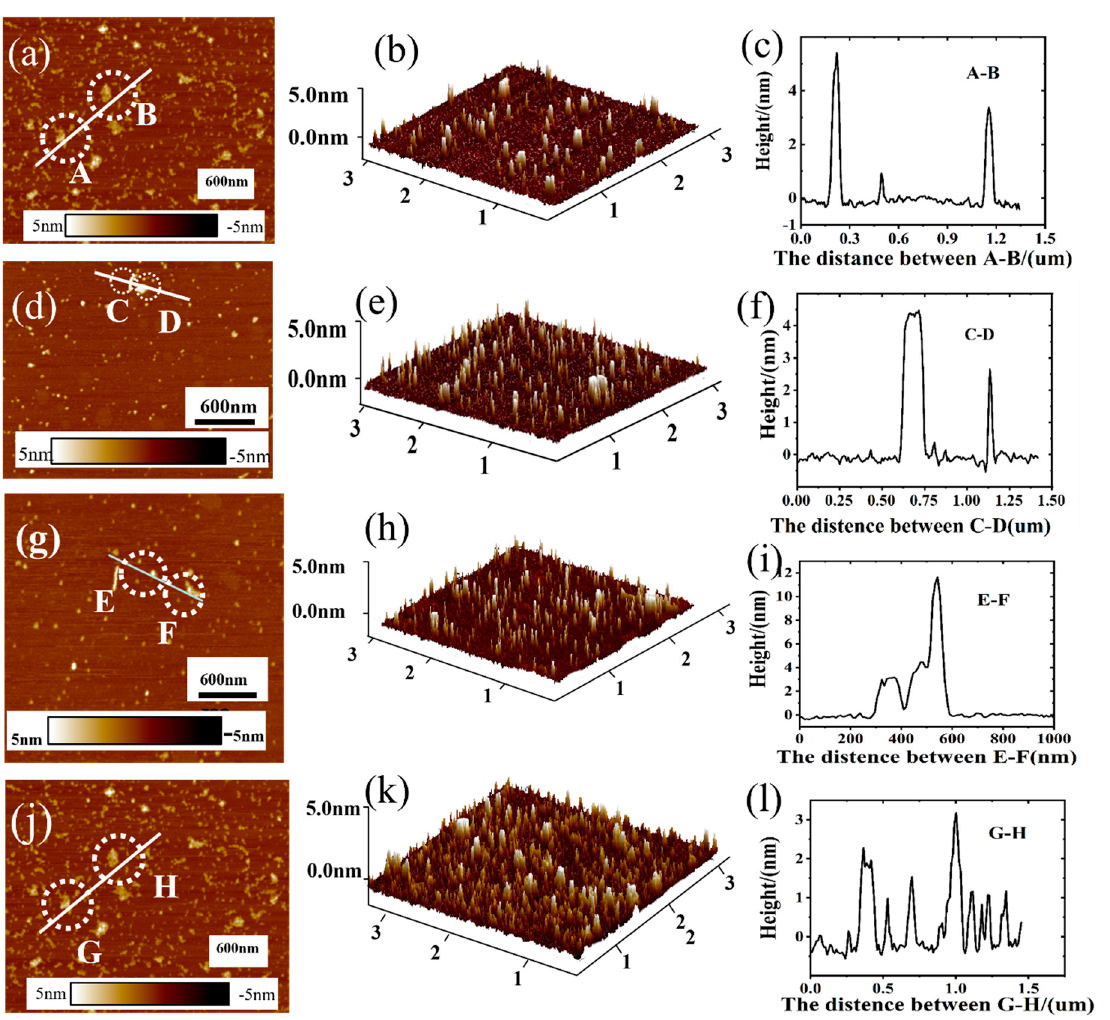
Figure 4. ( a , d , g , j ) 2D microscopic images of particles, ( b , e , h , k ) 3D morphology, and ( c , f , i , l ) burr height for each of the four liquor samples.